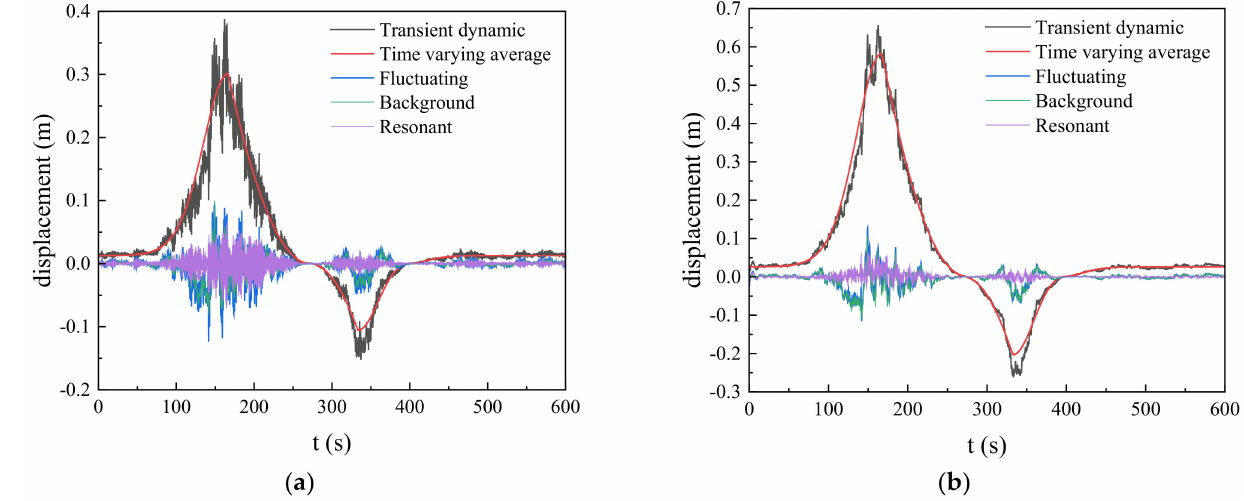
Figure 8. Time history of tower top displacement response: ( a ) single tower; ( b ) tower-line